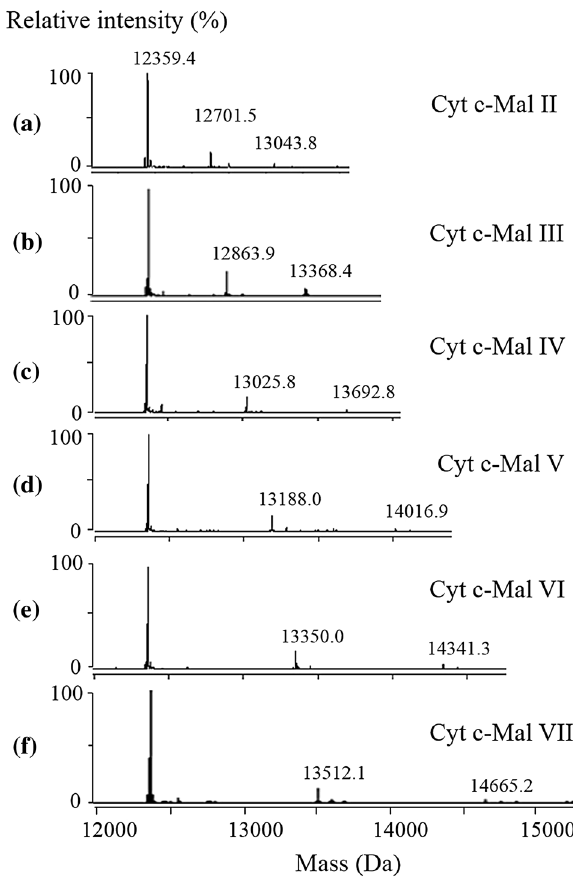
Fig. 3 Deconvoluted spectra for the complexes of cytochrome c with maltose ( a ), maltotriose ( b ), maltotetraose ( c ), maltopentaose ( d ), maltohexaose ( e ), maltoheptaose ( f ). The concentration ratio between Cyt and maltooligosaccharides is 1:10 ([Cyt c]:[Mal VII] = 1:12), while the concentration of Cyt is 0.50 l mol L - 1